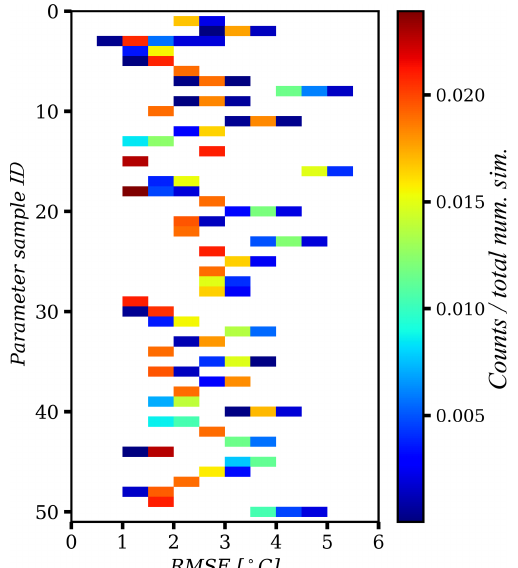
Figure 16. The 2-D histogram of parameter sample and RMSE. Only the simulations that reached the h T -non-oscillation condition are